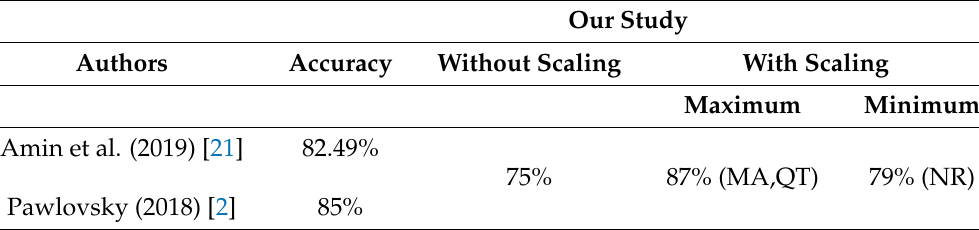
Table 10. Comparison with previous